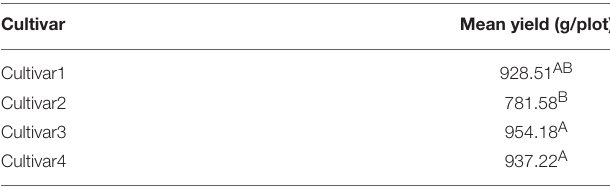
TABLE 3 | Differences in final yield between four